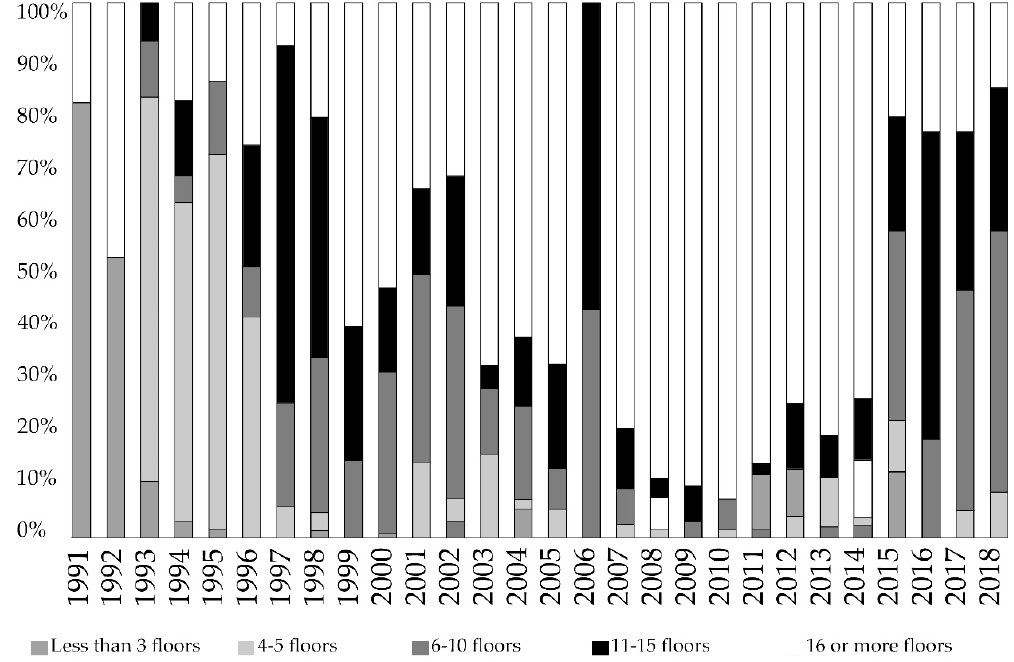
Figure 3. Composition of new buildings in the commune of Santiago Centro between 1991 and